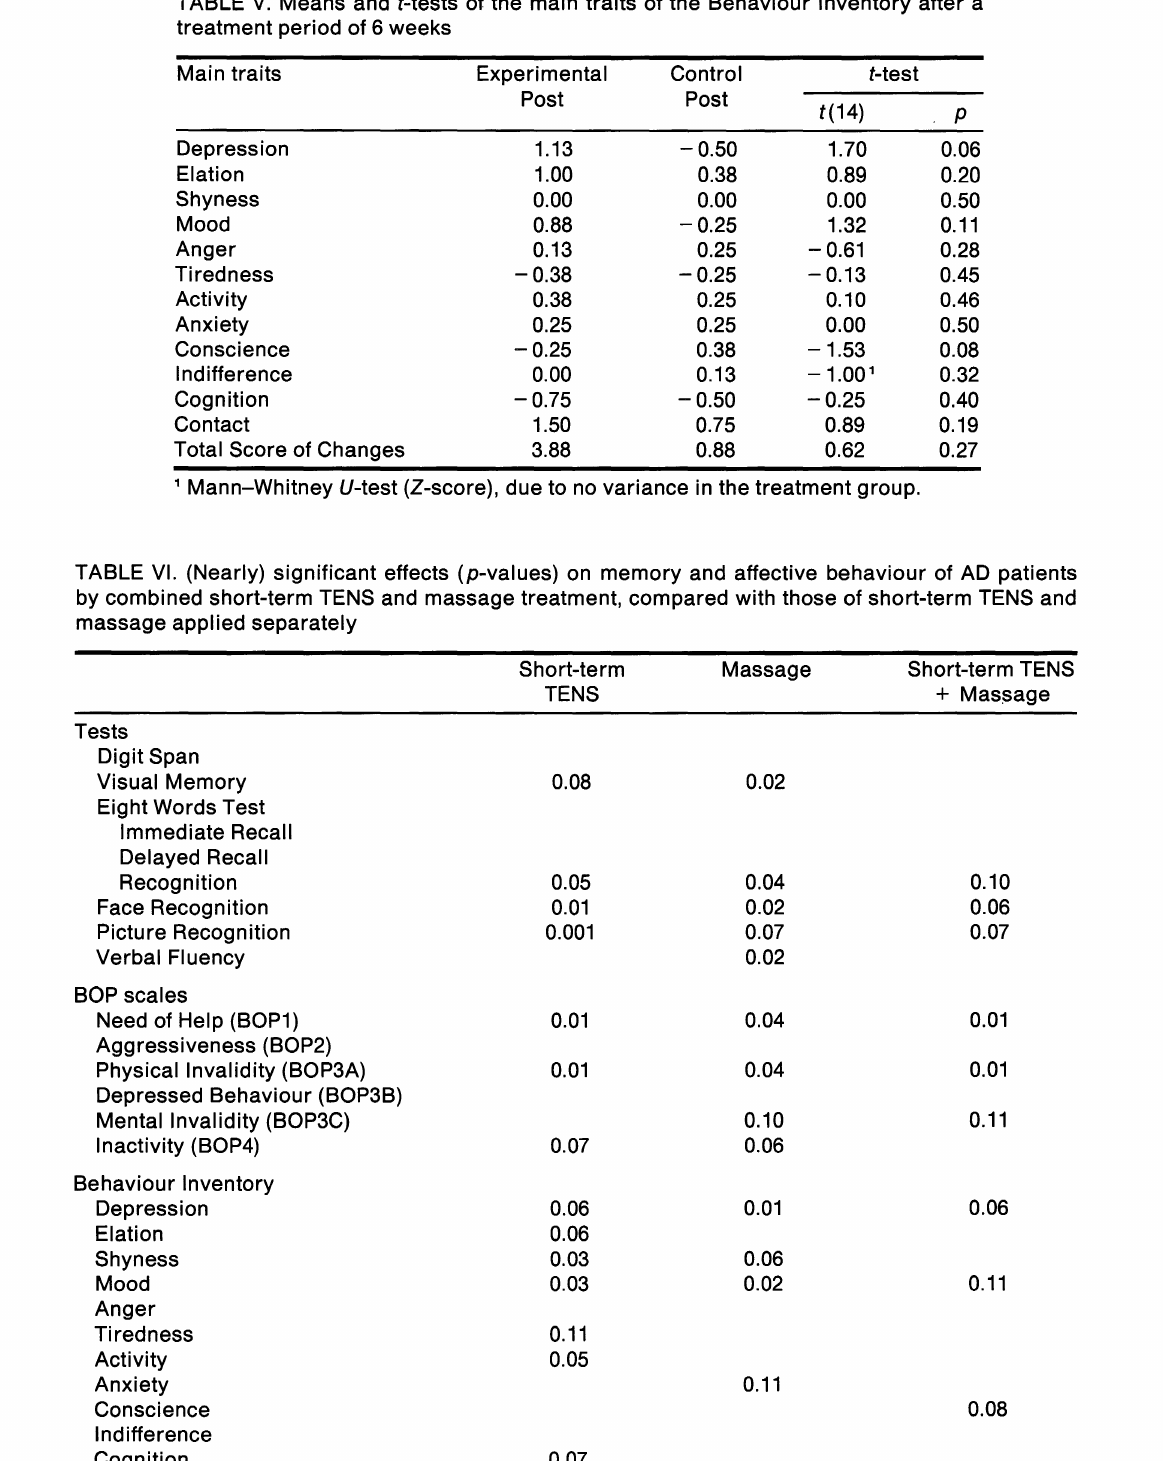
TABLE V. Means and t-tests of the main traits of the Behaviour Inventory after a treatment period of 6 weeks Main traits